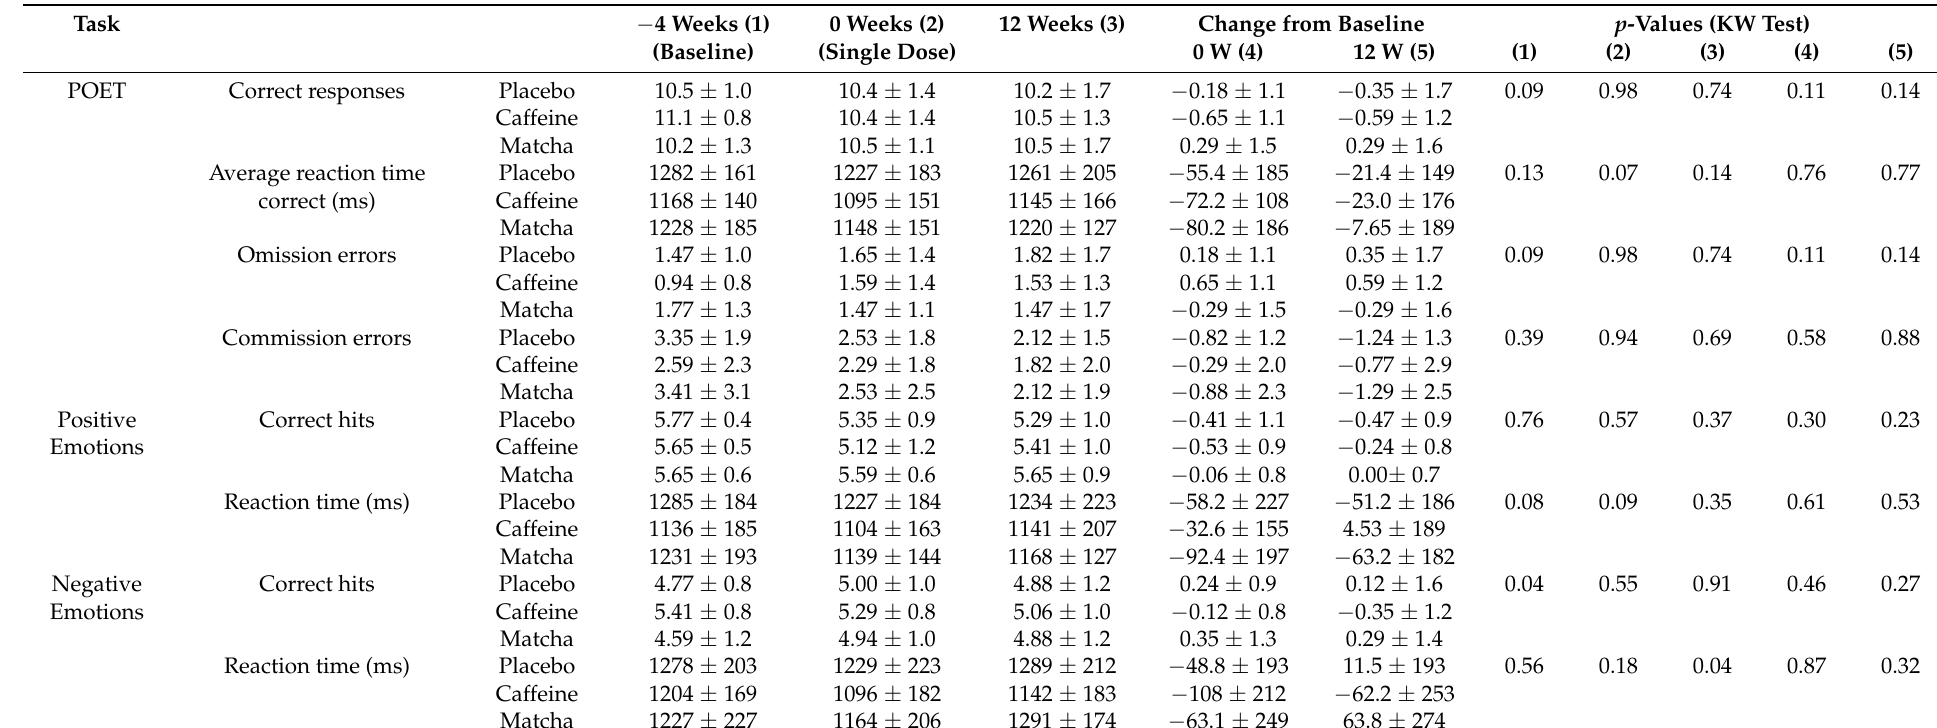
Table 6. Effect of matcha or caffeine intake on facial expression recognition-related